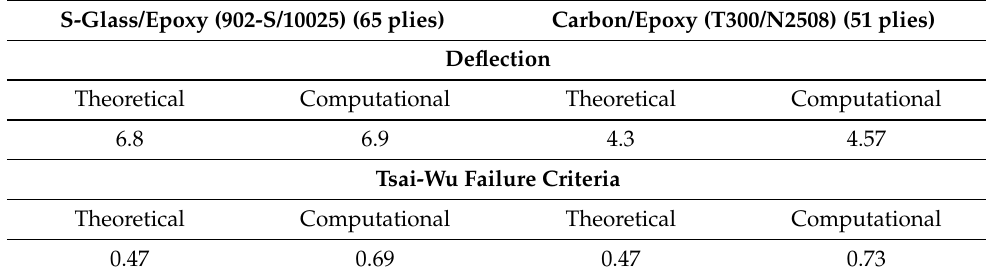
Table 5. Comparison of theoretical and computational results of deflection and Tsai-Wu failure criterion for S-glass fiber/epoxy and T300 carbon fiber/epoxy.